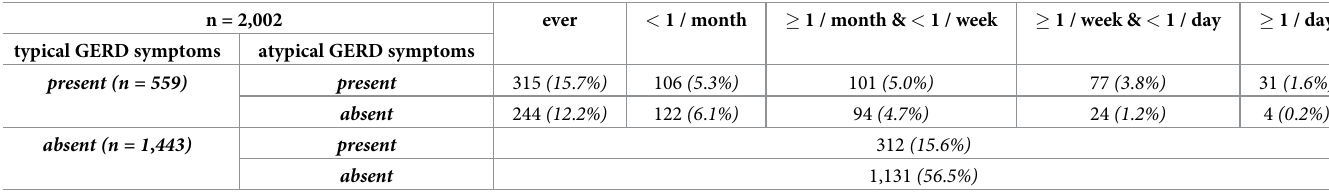
Table 1. The presence of the typical and/or atypical